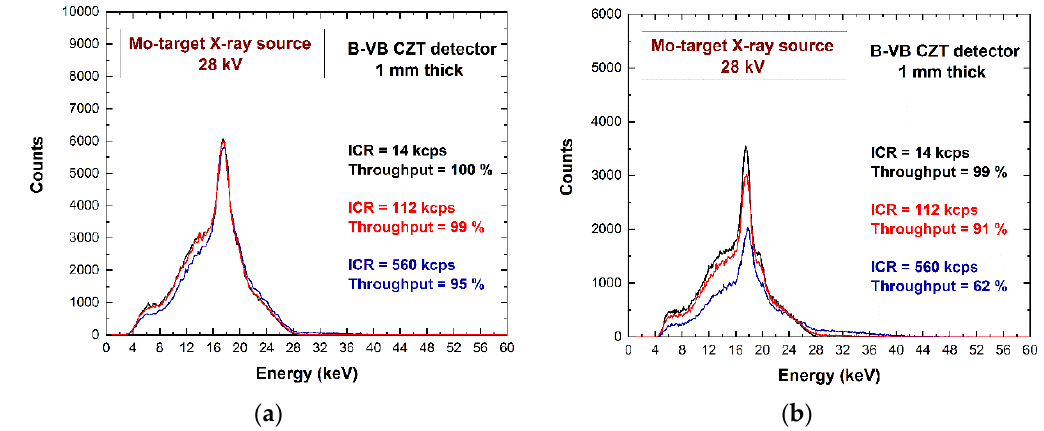
Figure 12. The Mo-target X-ray spectra at different input counting rates (ICRs). ( a ) Ballistic deficit pulse processing; ( b ) energy resolution pulse processing.